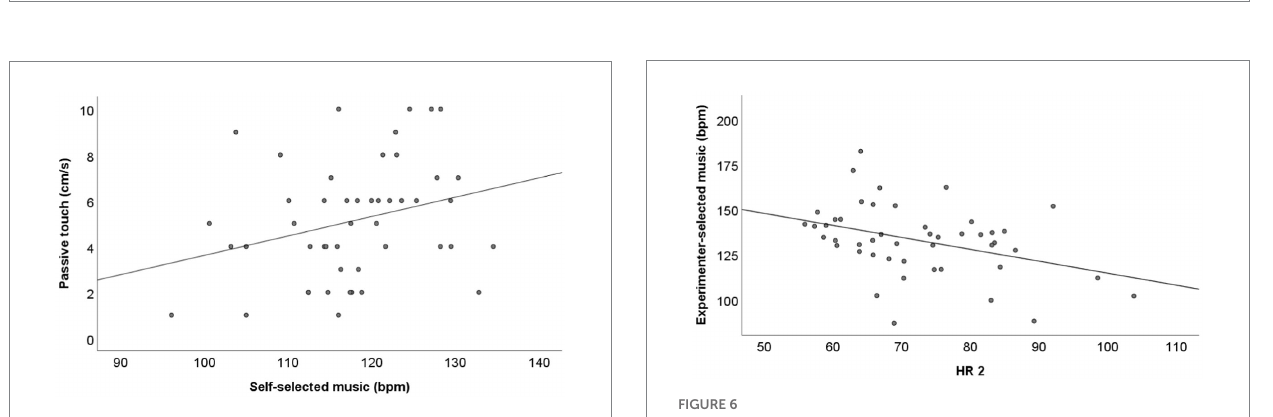
FIGURE 5 Passive touch (cm/s) against self-selected music (bpm) with regression line.